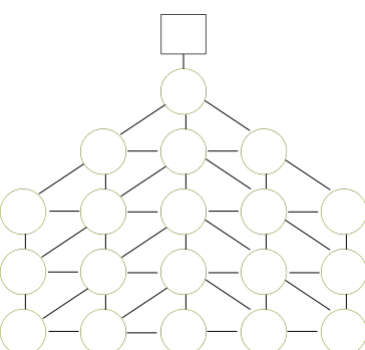
Figure 3. A Data Foraging Graph is created from the Hextille of Figure 2. The square represents the base station while the circles represent the regions of the Hextille. Every region has adjacent regions which are connected with edges between the circles.